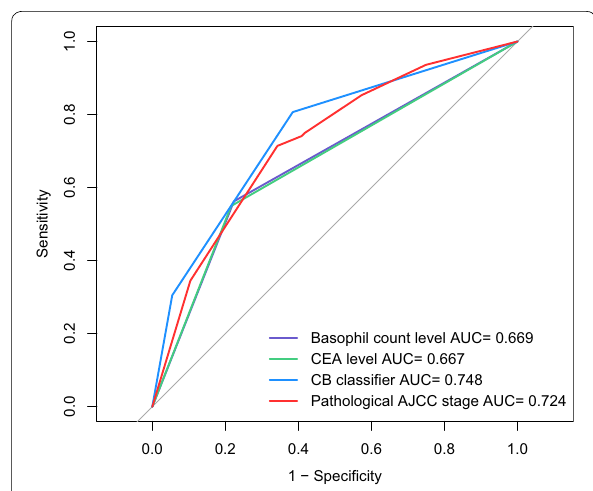
Fig. 2 Receiver operating characteristic curves for serum basophil count level, CEA level, CB classifier and pathological AJCC